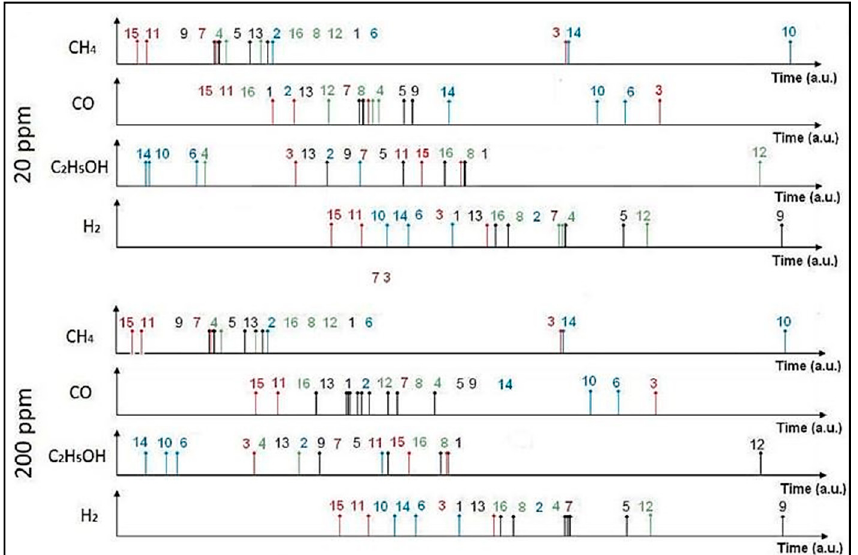
Figure 2. Rank-order signature for four gases, CH 4 , CO, C 2 H 5 OH, and H 2 , generated by 4 × 4 metal oxide sensor array adapted from [15] .